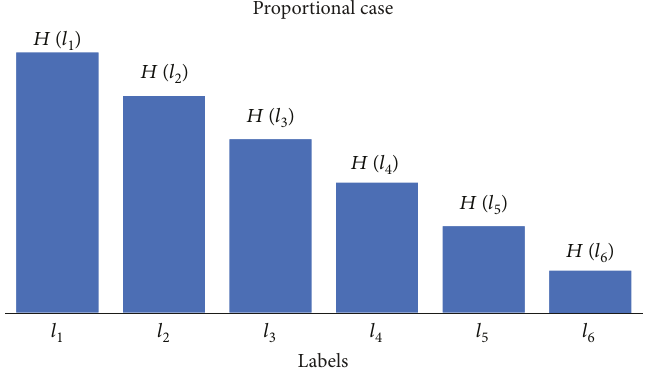
Figure 4: Score value calculation when label entropy values are proportional to their